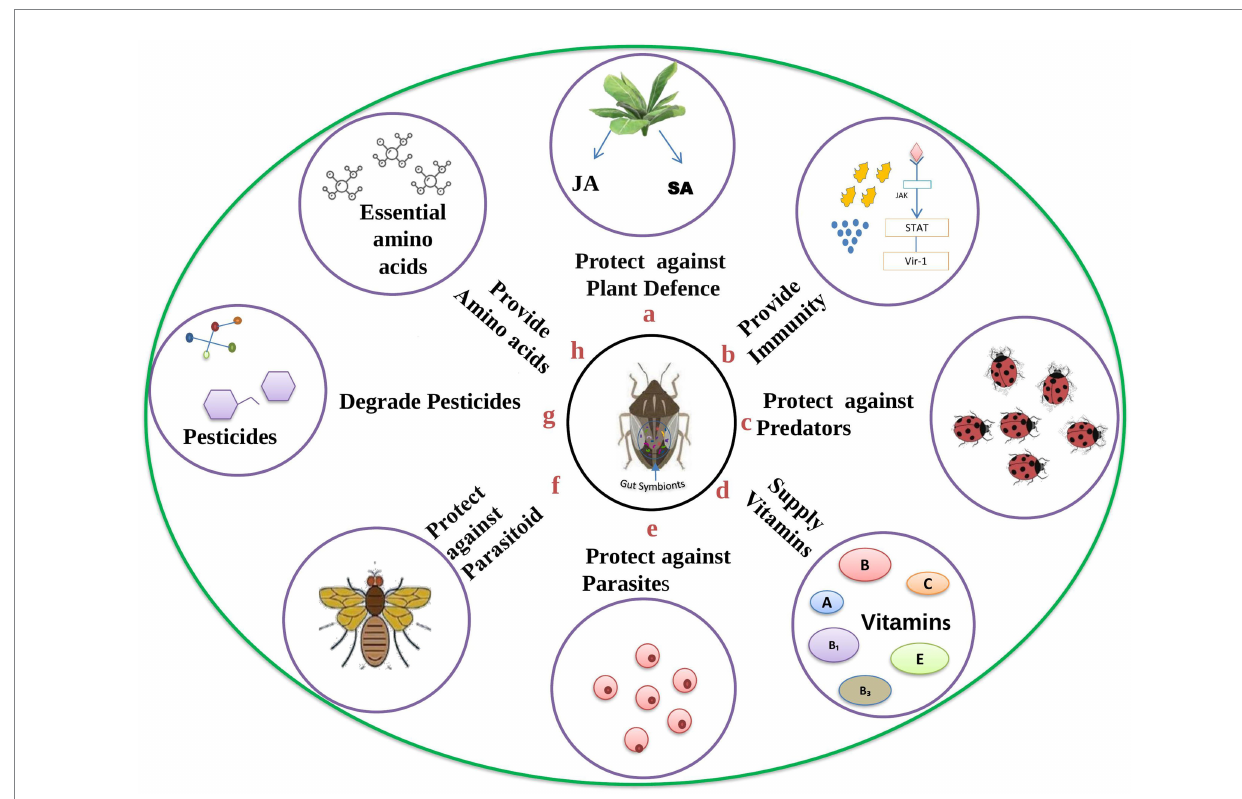
FIGURE 2 Diverse roles played by gut symbionts in the insect host body: The given figure depicts the various roles played by gut symbionts in the insect host body. (A) Plants secrete jasmonic acid (JA) and salicylic acid (SA) as a defence mechanisms against insect pests, but gut symbionts can degrade and protect the insect from these plant defences; (B) symbionts play a crucial role in shaping insect immunity via various pathways; (C) insects can change their morphological features due to the presence of symbionts which in turn helps the host in getting protection from predators; (D) insects feed on plant sap which is devoid of essential nutrients, but the presence of symbionts satisfies the need for essential nutrients; (E) symbionts secrete counter effective molecules that act on pathogens and prevent insects from becoming infected; (F) parasitoid wasp lays eggs on insect bodies, but once the egg hatches into a larva, the presence of symbionts halt the further development of the larva and the host is protected; (G) gut symbionts can break down pesticides into less harmful products; (H) insects cannot synthesize essential amino acids, but symbionts synthesize and fulfill the need of the host insect.